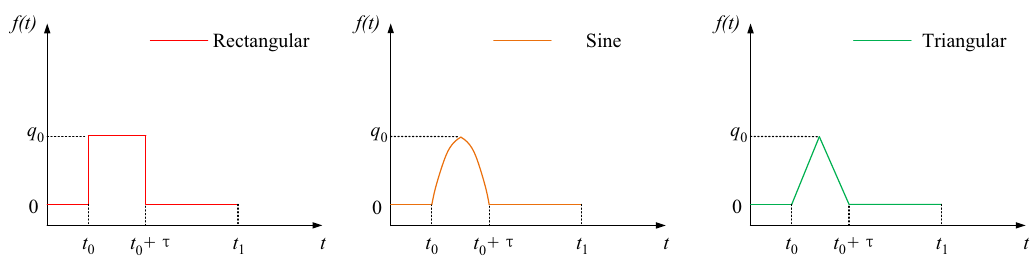
Figure 13: Sketch of applied load for rectangular plate with three di ff erent types of time - dependent